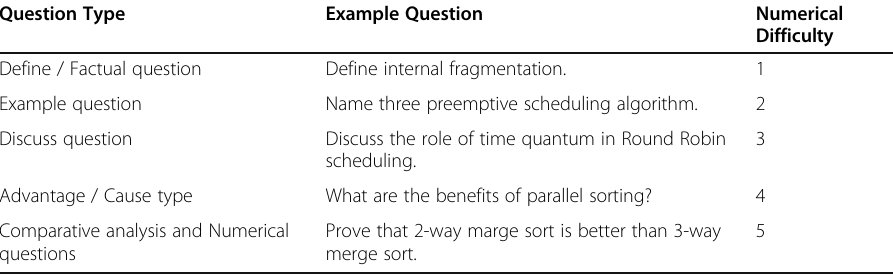
Table 2 Question type and corresponding numerical difficulty value Question Type